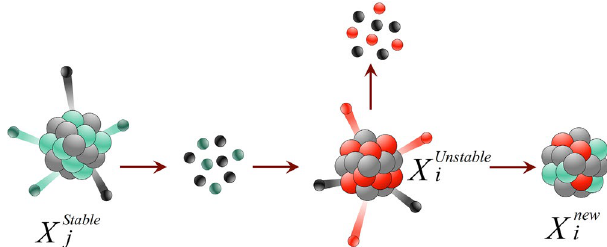
Figure 10. Procedure of β -decay in an unstable